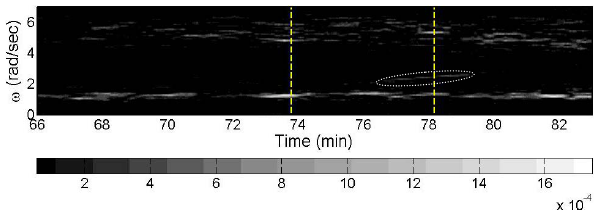
Figure 14. Time-frequency spectrum (extracts 60 sec) of the record of 13 July 2008; shades of Fig. 14. Time-frequency spectrum (extracts 60s) of the record of grey indicate the spectral density; dashed lines correspond to the time of the freak wave 13 July 2008; shades of grey indicate the spectral density; dashed occurrence; the ellipse corresponds to the dispersive track. lines correspond to the time of the freak wave occurrence; the el- lipse corresponds to the dispersive